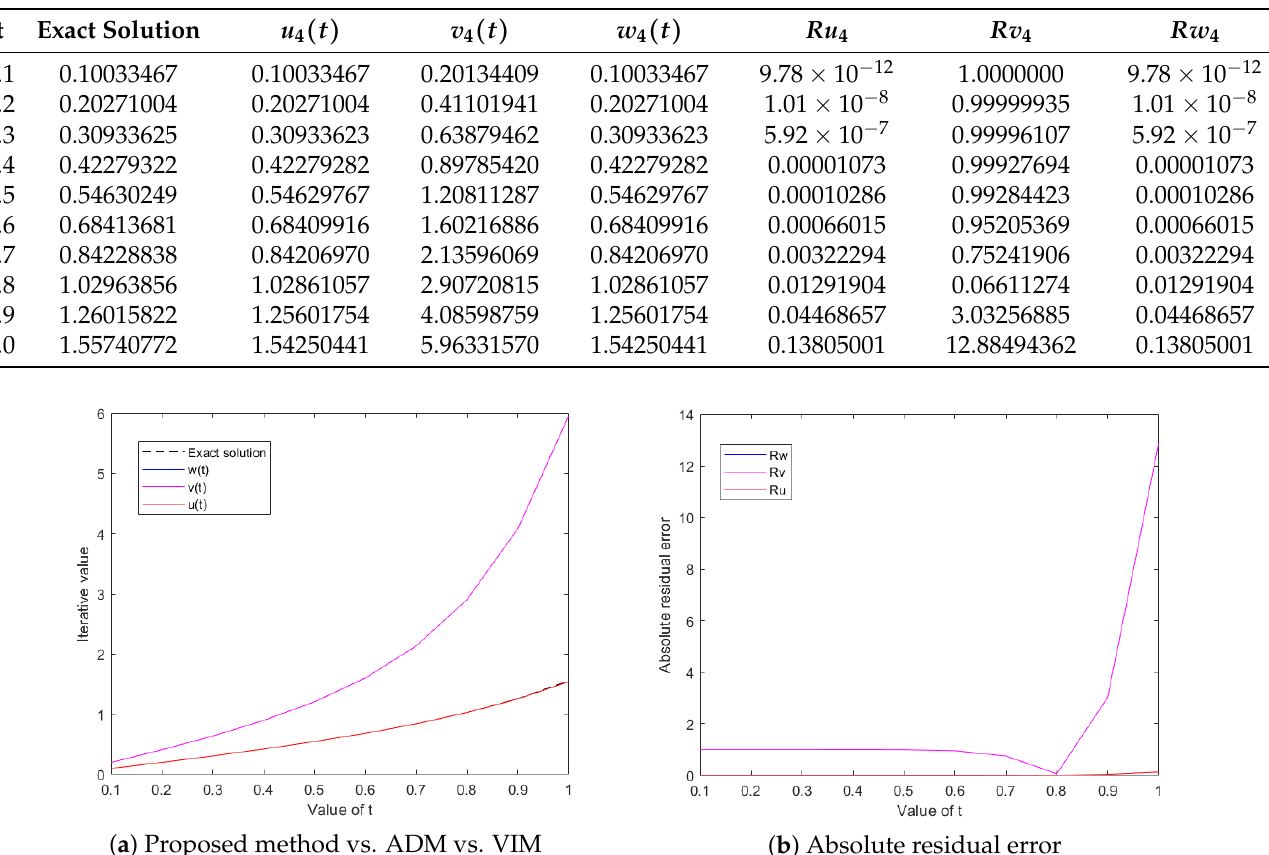
Table 3. Comparison of numerical results for Example 3.